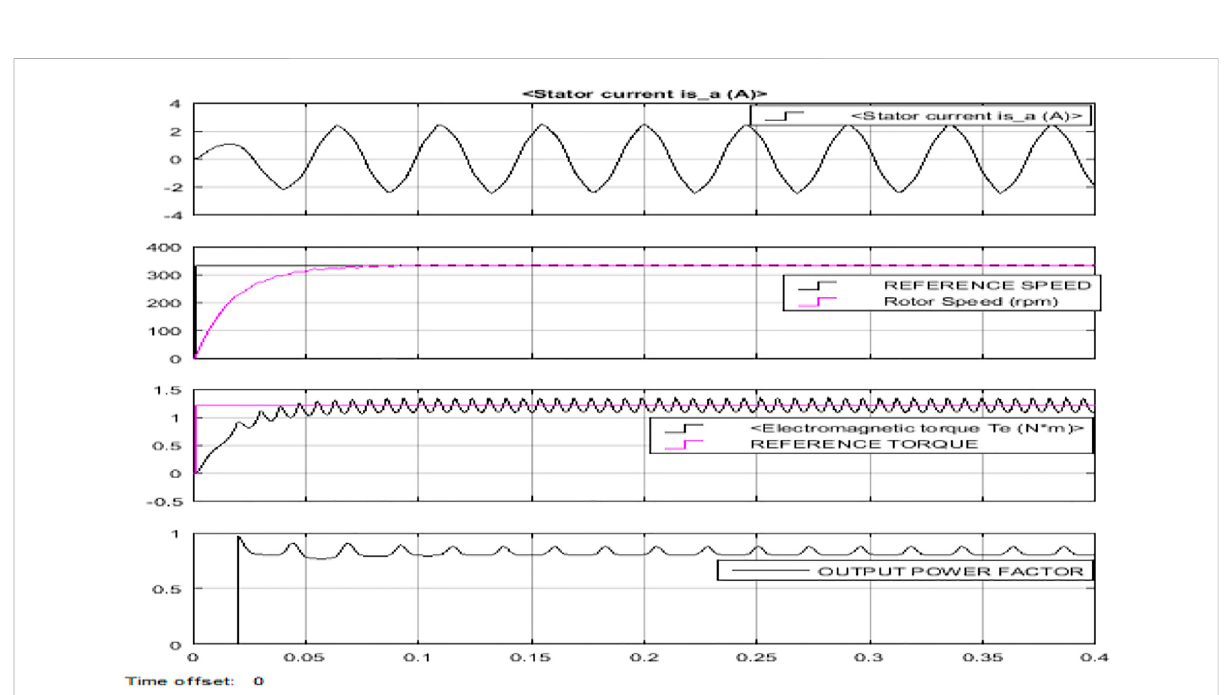
FIGURE 16 Output parameters of BLDC motor